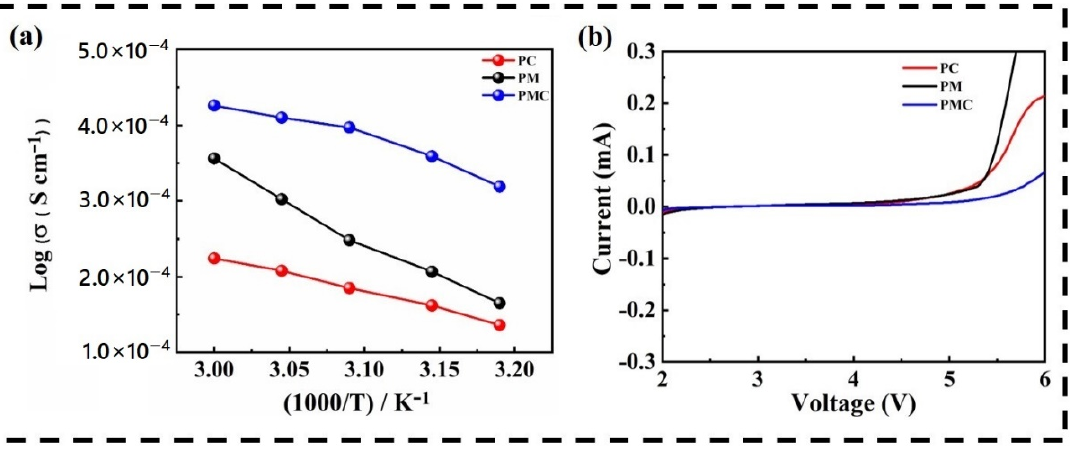
Figure 6 . ( a ) Ionic conductivity measurements of PC, PM, PMC GPEs at various temperatures; ( b ) LSV plots of as-prepared dry polymer membranes.